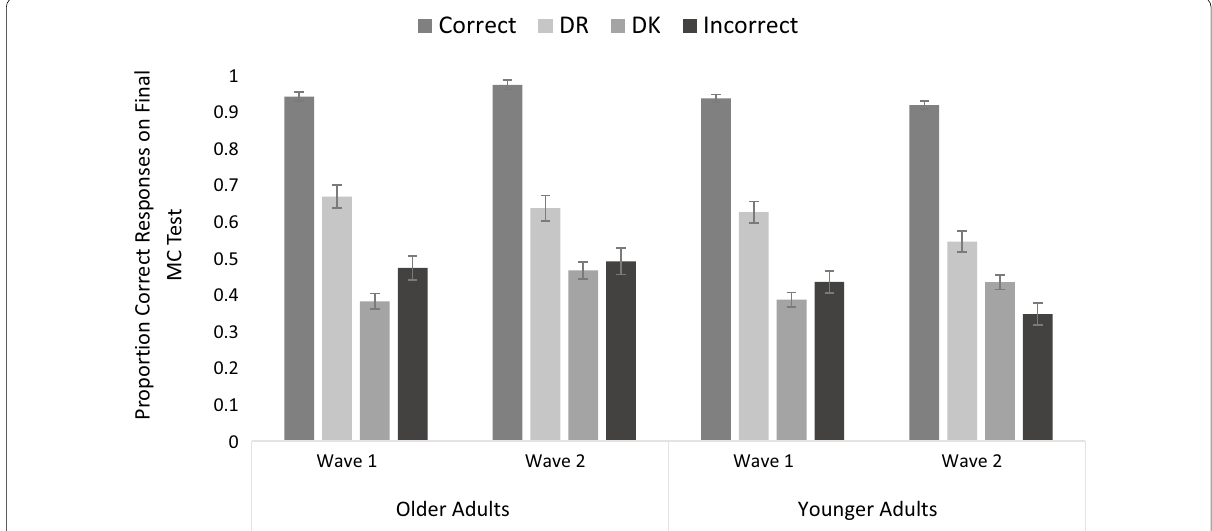
Fig. 2 Accuracy on the final MC test in Waves 1 and 2 as a function of response on the initial test and age (error bars reflect standard error of